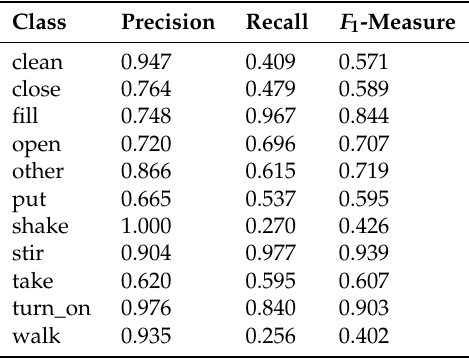
Table 8. Detail evaluation for classes in bigger CMU subset with best configuration which is random forest with early